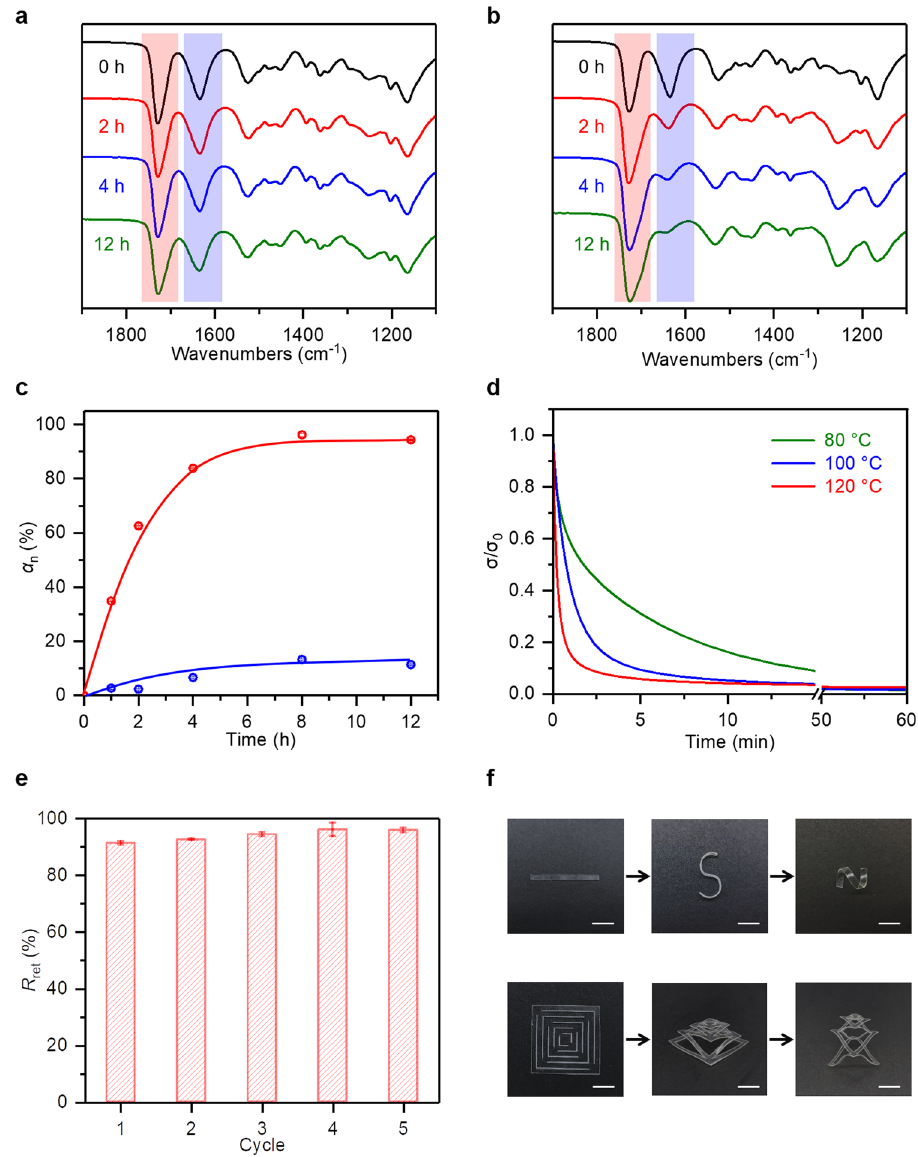
Fig.3|Theexchangereactionsinapolymernetwork(HUBM-co-HBA).a , b Time evolutions of the Fourier transform infrared (FTIR) spectra at 80 and 120°C, respectively. c The conversions from hindered urea to urethane ( α n ) at 80 and